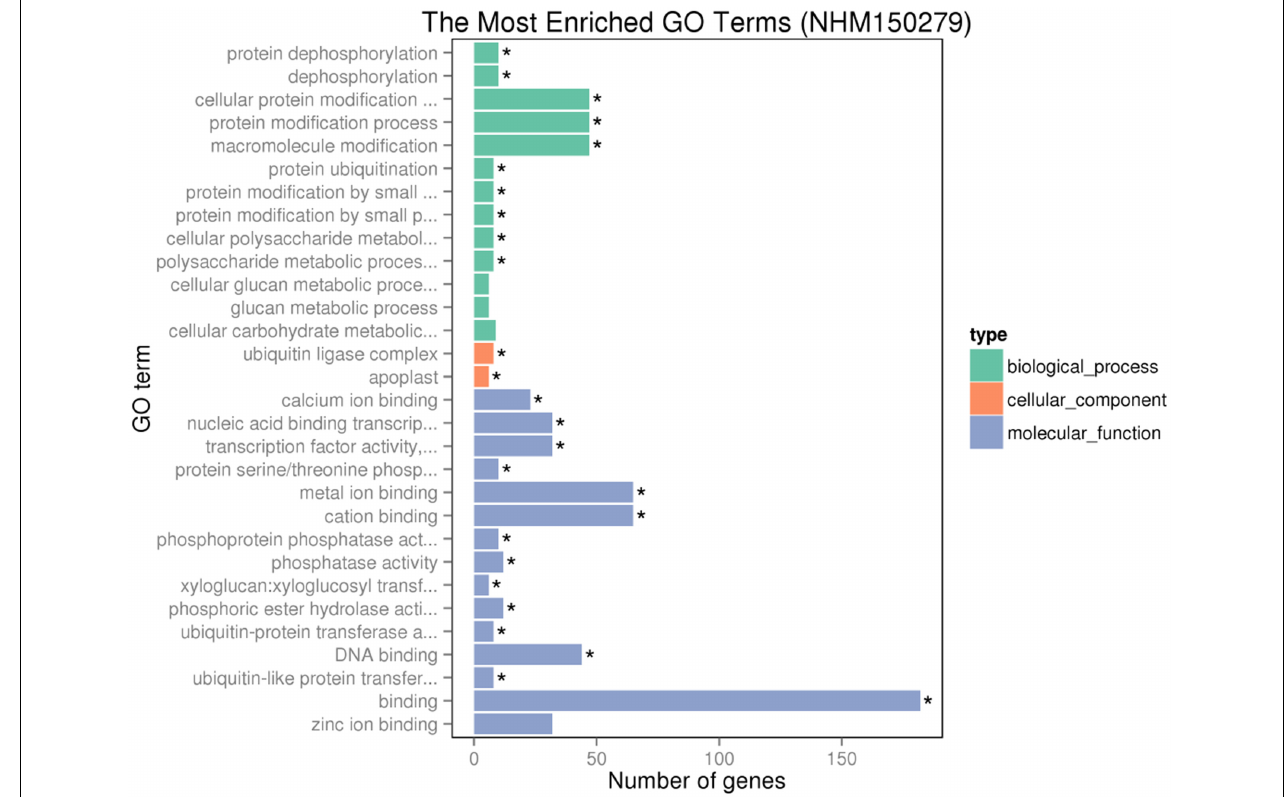
FIGURE 9 | Gene ontology (GO) analyses of the 342 common DEGs after GR24 treatment. The DEGs were assigned into three groups with different colors, including biological process (BP), cellular components (CCs), and molecular function (MF). The x -axis represents the number of genes in each category, and y -axis represents the most abundant categories in each